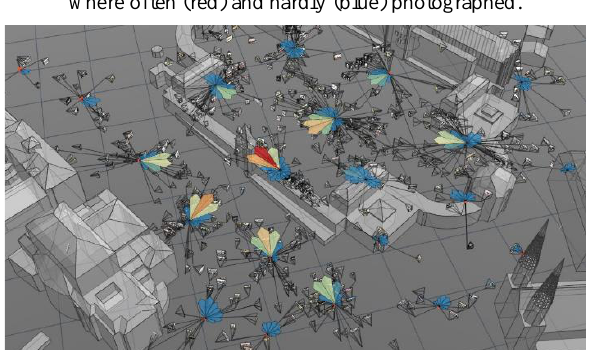
Figure 4 . Advanced heat map showing which building parts where often (red) and hardly (blue) photographed.